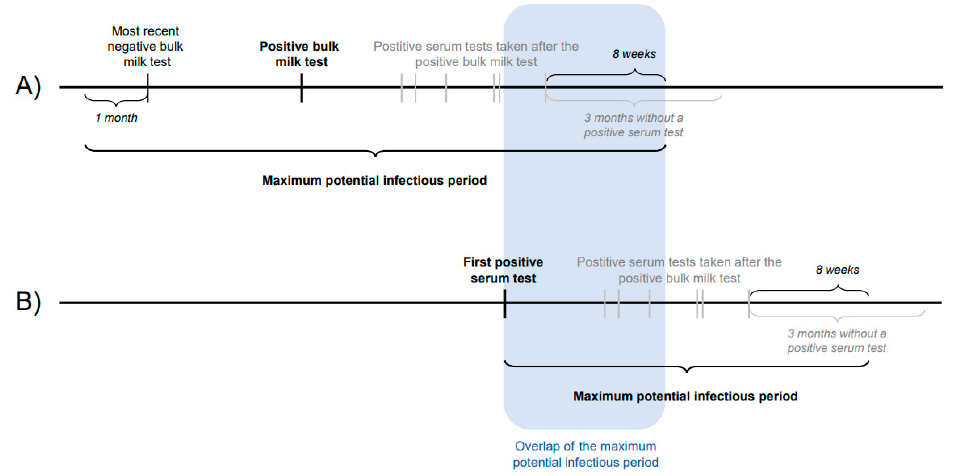
Figure 2. Graphical depiction of the definition of the maximum potential infectious period of a herd, if it became suspected due to ( A ) a positive bulk milk sample or ( B ) a positive serum sample.